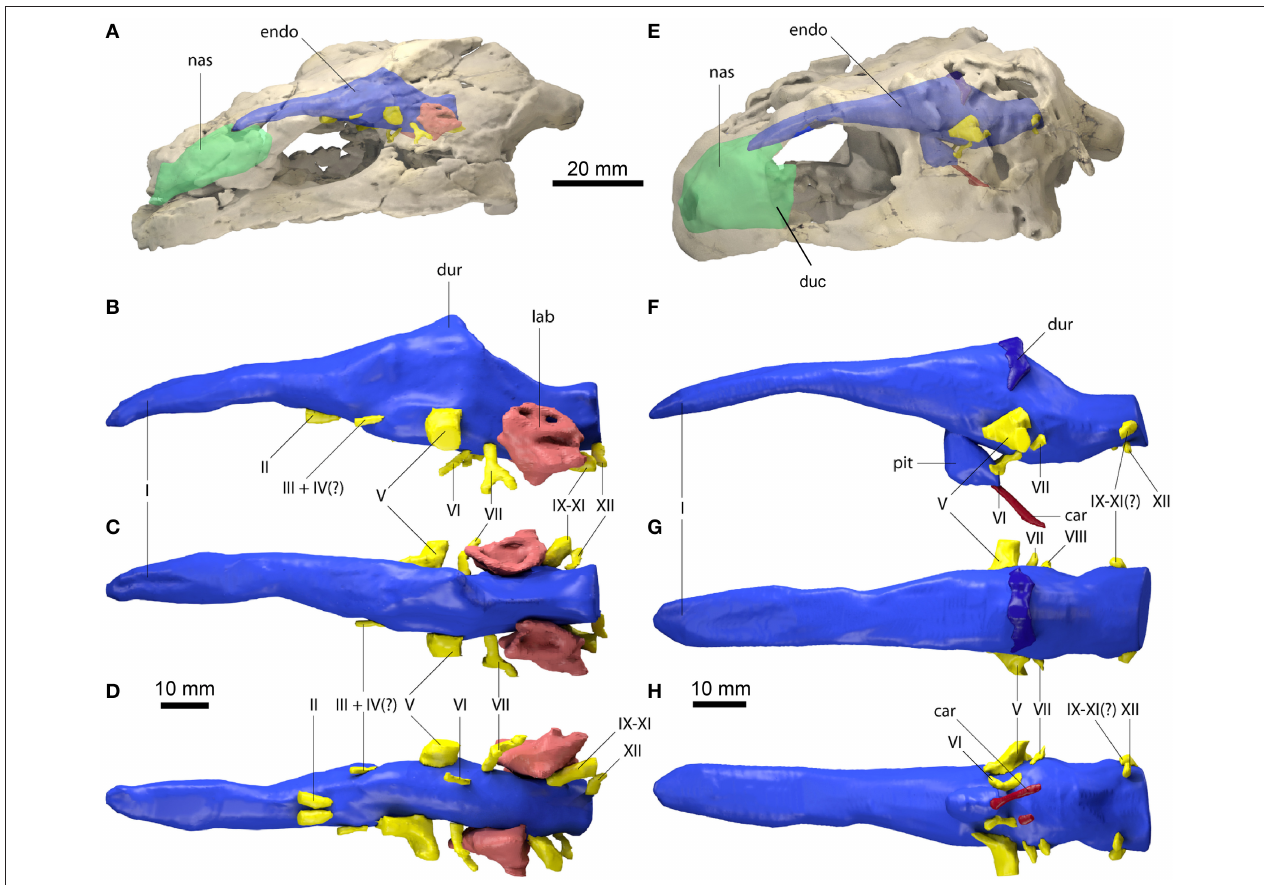
FIGURE 1 | Endocranial anatomy of Proganochelys quenstedti specimens (A–D) MB 1910.45.2 and (E–H) SMNS 16980. Endocast and nasal cavity (A,B) in situ in left lateral oblique view with bone rendered semi-transparent and isolated endocast in (B,F) left lateral, (C,G) dorsal and (D,H) ventral views. car, carotid artery; duc, ductus nasopharyngeus; dur, dural peak; endo, brain endocast; lab, endosseous labyrinth; nas, endocast of nasal cavity; pit, pituitary fossa; I, olfactory nerve; II, optic nerve canal; III, oculomotor nerve canal; IV, trochlear nerve canal; V, trigeminal nerve canal; VI, abducens nerve canal; VII, facial nerve canal; IX-XI shared canal for the glossopharyngeal, vagus and spinal accessory nerve; XII, hypoglossal nerve canal.